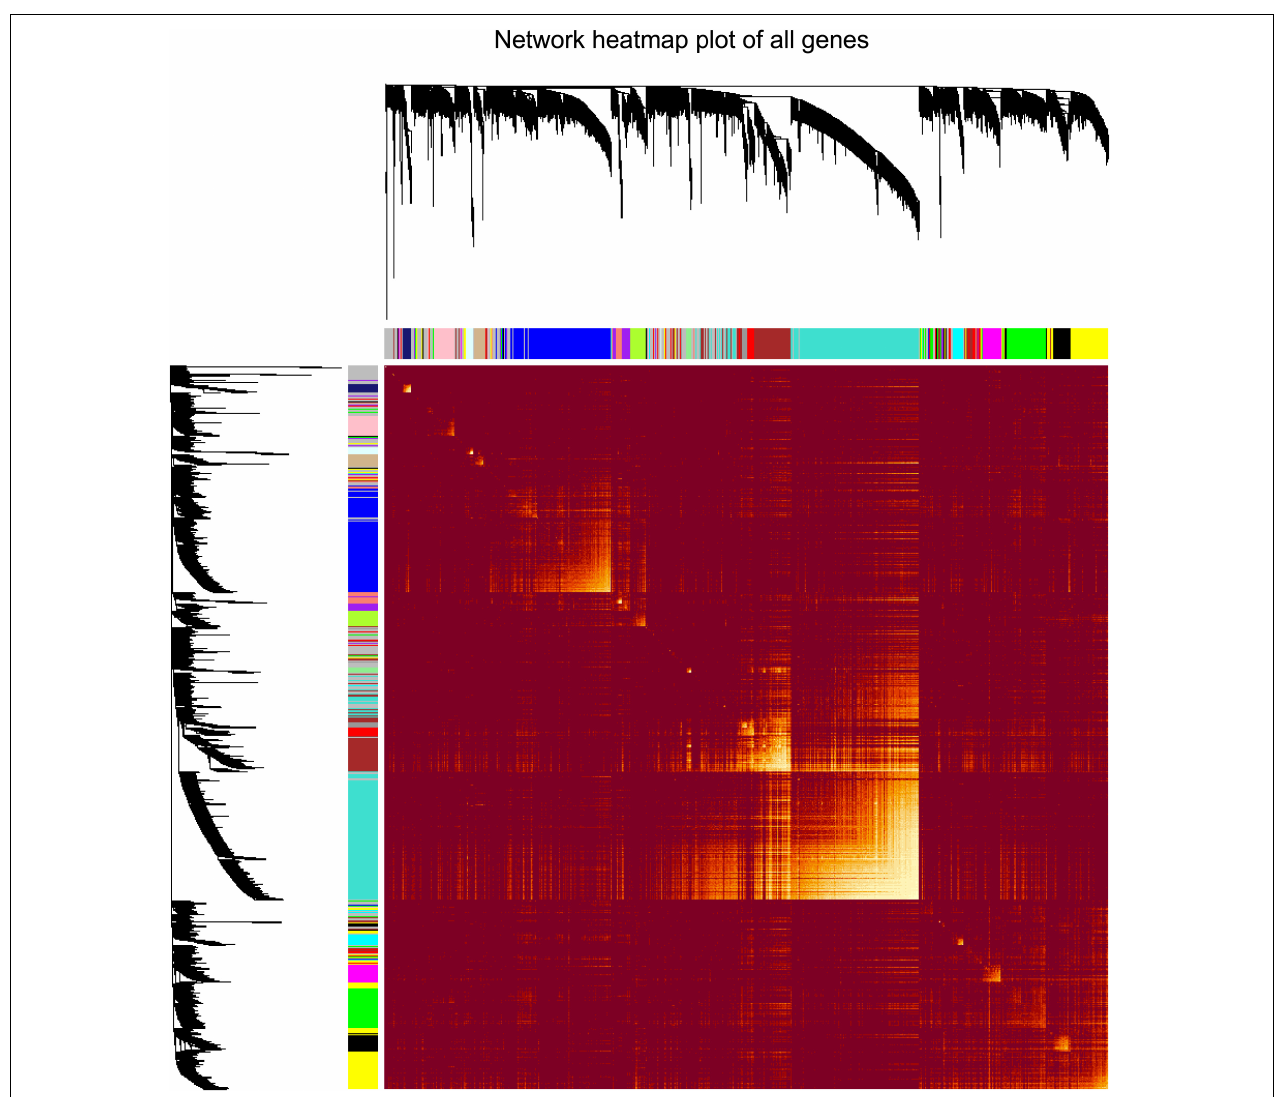
FIGURE 2 | Analysis of co-expressing genes modules. Topological overlap matrix plot of all genes. Genes in the rows and columns are sorted by the clustering tree. Different colors of the horizontal axis and vertical axis represent different modules. The brightness of yellow in the middle represents the degree of connectivity of different